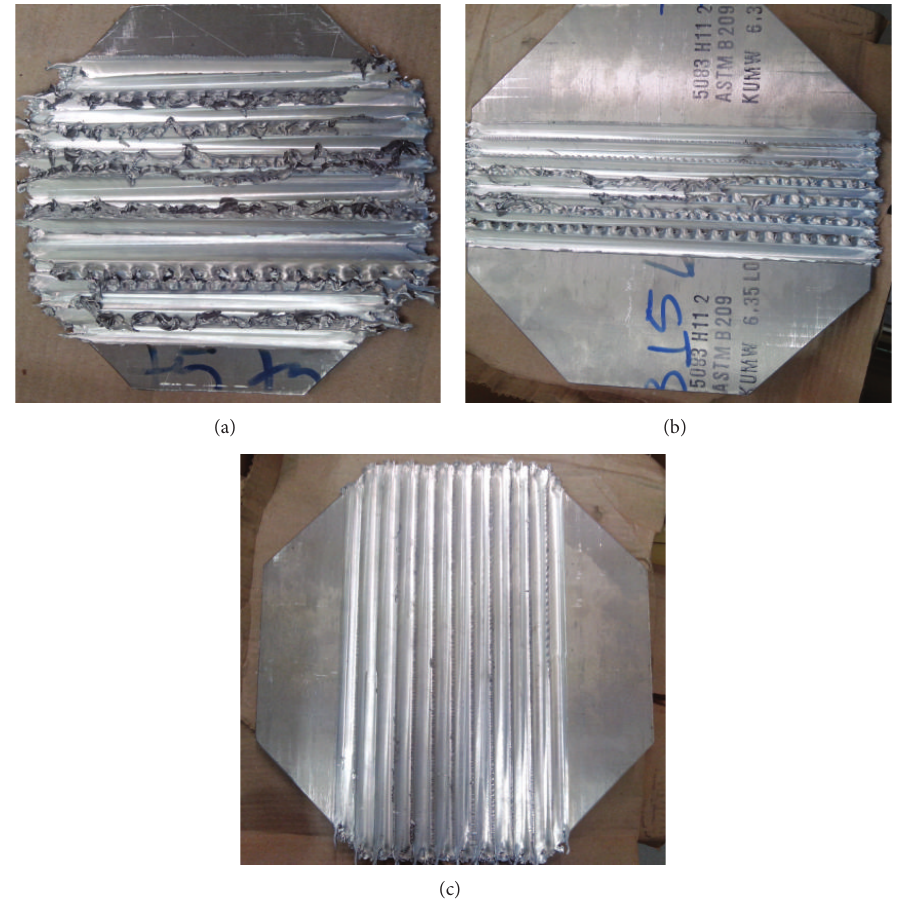
Figure 35: AA-5083 sheets processed for the bulge tests. (a) Circular tool. (b) 10 × 4 ellipse. (c) 10 × 7 ellipse.